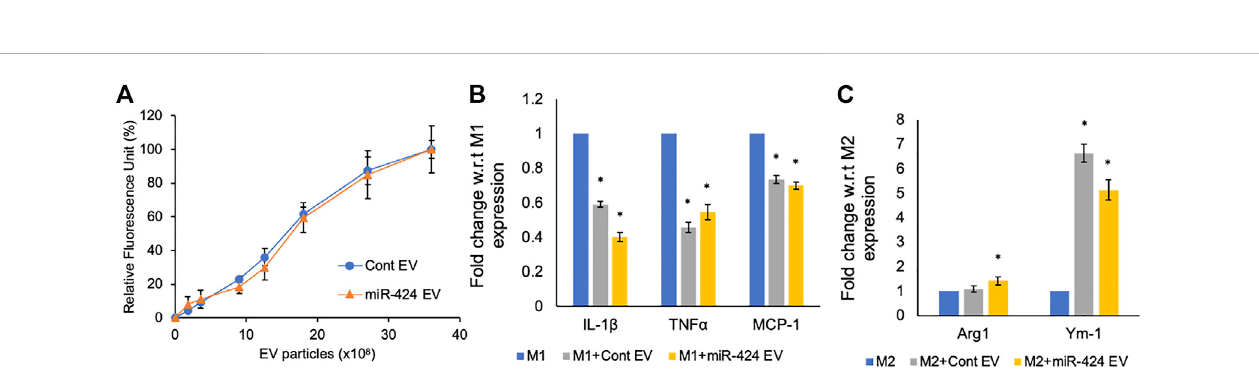
FIGURE 5 In vitro Immunomodulatory properties of the engineered EVs. (A) Graph representing the dose dependent endocytosis of fl uorescently labeled control and424 EVs byprimarymousebonemarrowderived macrophages.Nosigni fi cantdifferenceswereobserved. (B) Mean(+/-)fold change inexpression levels of pro-in fl ammatory markers in M1 polarized macrophages in the absence/presence of control or engineered EVs. (C) Mean (+/-) fold change in expression levelsofpro-reparativemarkersinM2polarizedmacrophagesintheabsence/presenceofcontrolorengineeredEVs.*representsstatisticalsigni fi cance with respect to control measured by Tukey ’ s test post